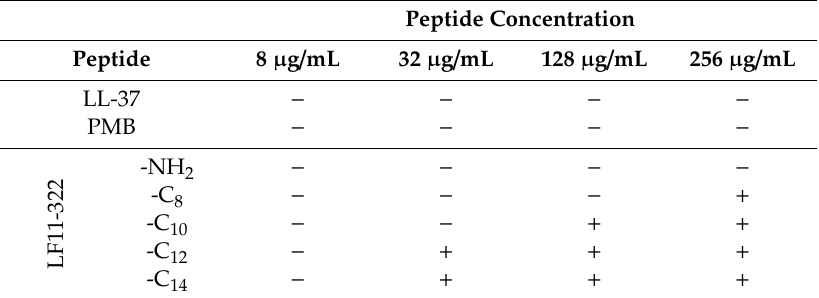
Table 4. Influence of acyl chain length of the LF11-322 peptide on plasmatic coagulation. Peptide Concentration Peptide 8 µ g / mL